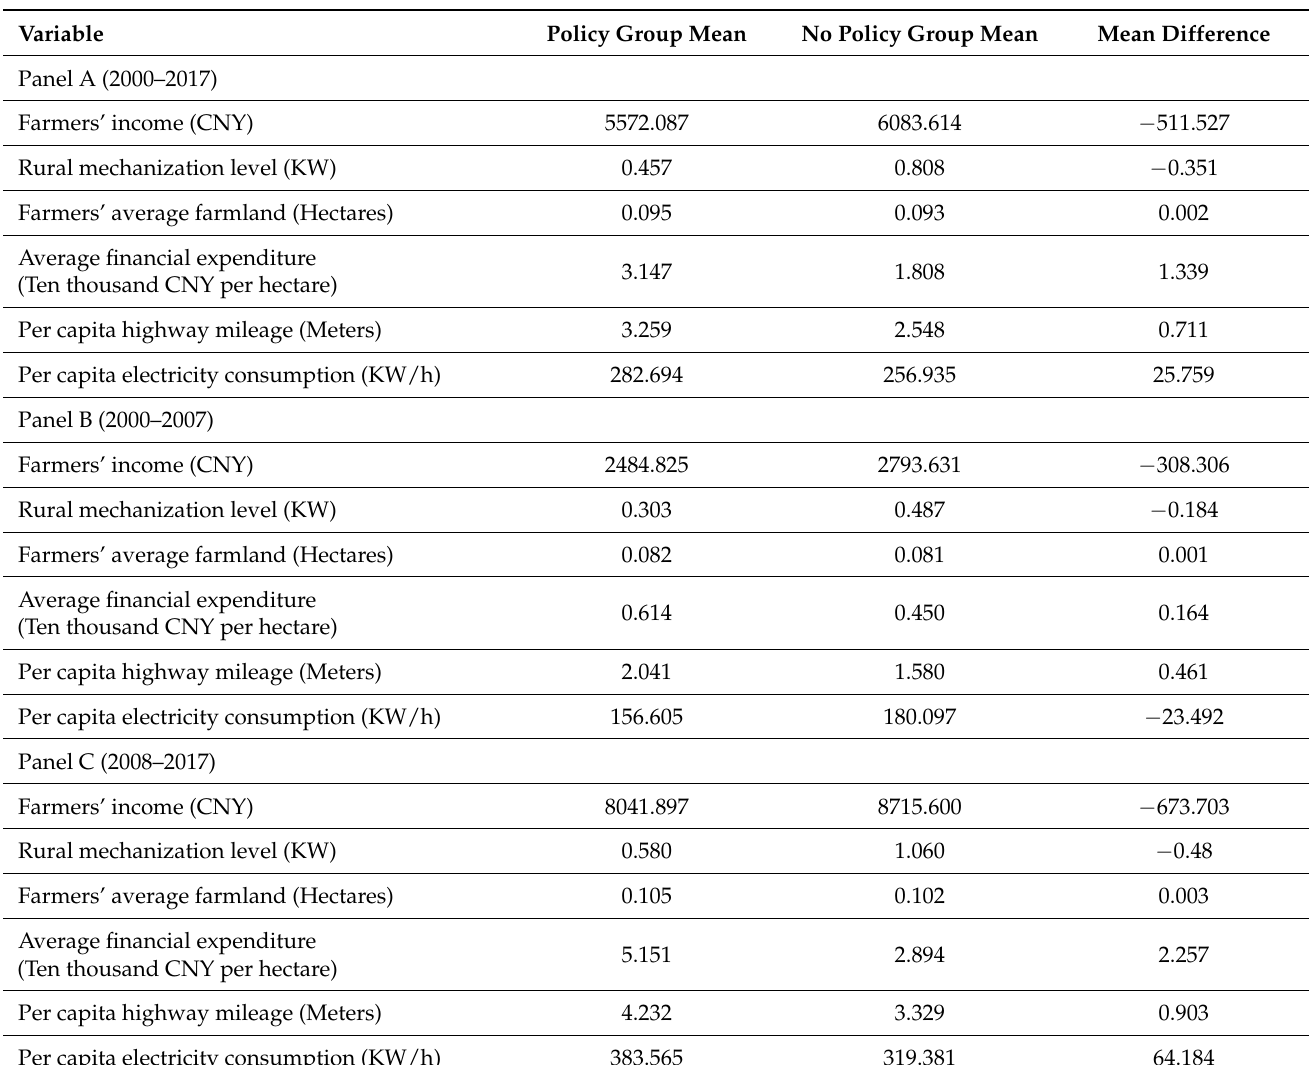
Table 2. Comparison of economic development between Chongqing and the other four provinces from 2000 to